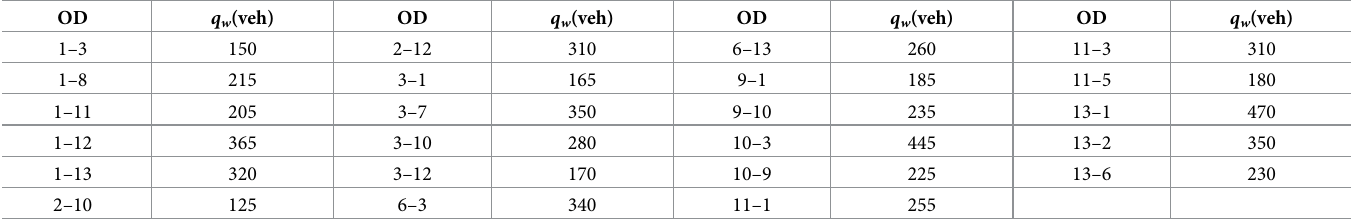
Table 4. Daily traffic demands between the 23 OD